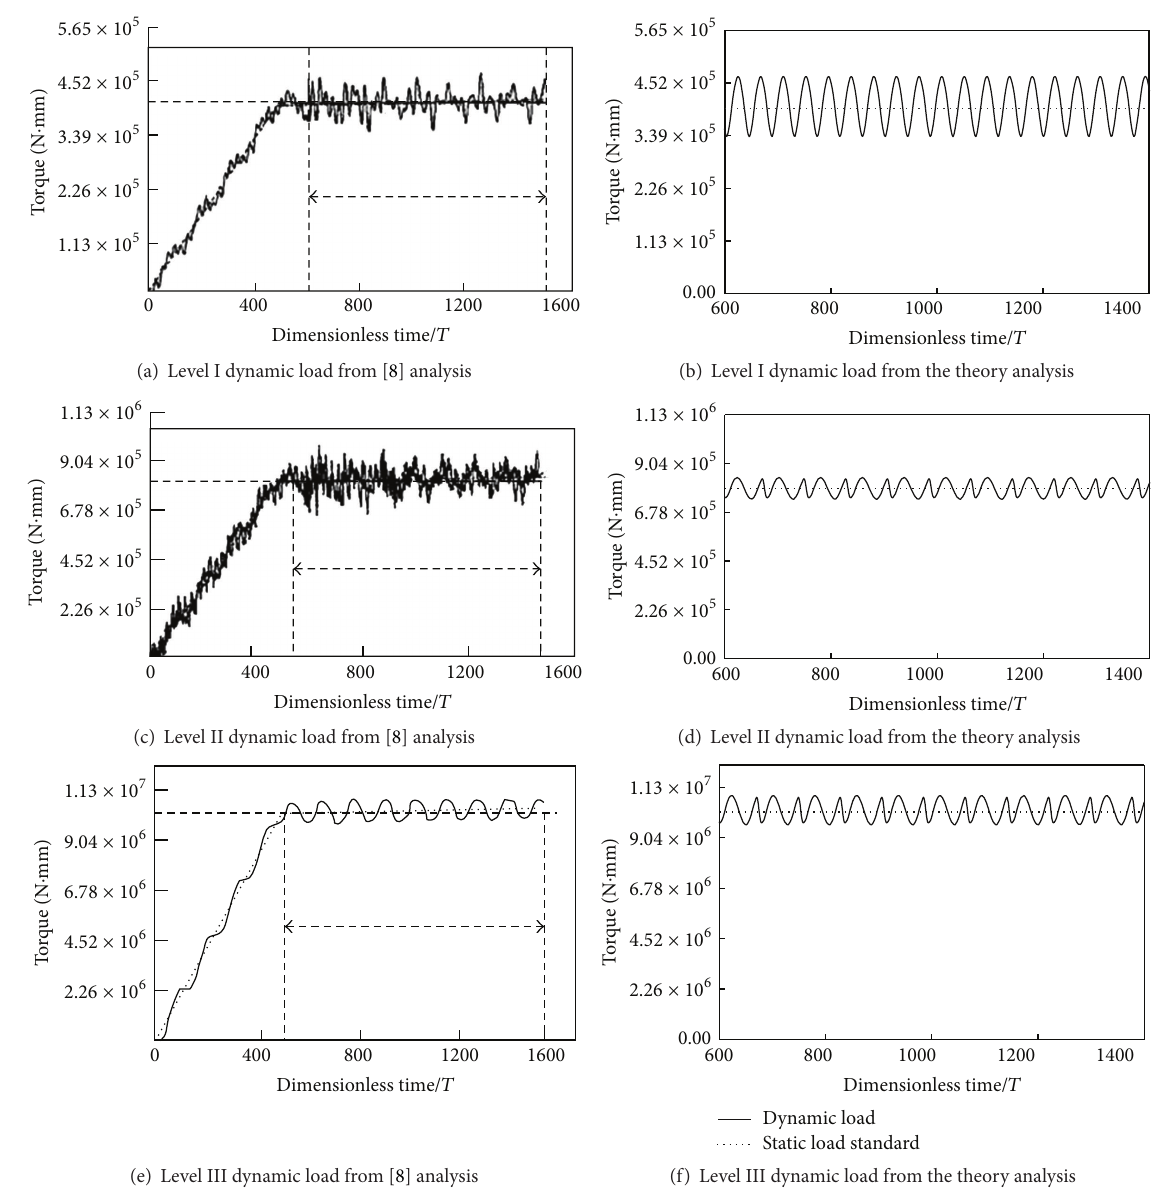
(f) Level III dynamic load from the theory analysis Figure 18: Contrast between theory analysis and [8] calculation of dynamic load.